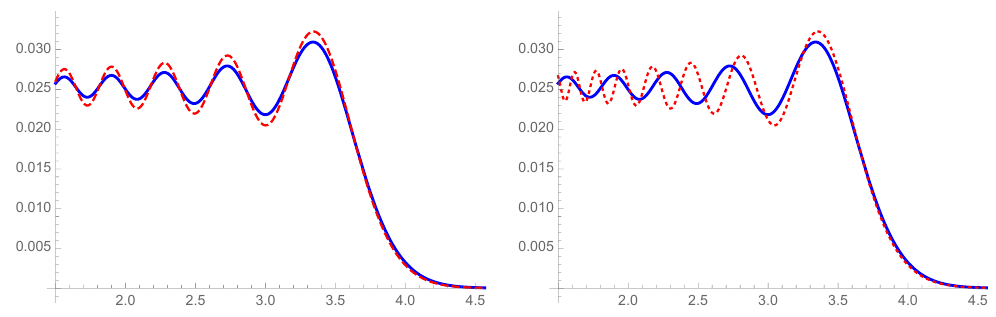
Figure 6 . Comparison of ( x; p ) (in blue solid) with its semiclassical approximations, for local Q N F 0 . On the left, the red dashed line is the expression (3.70) involving the chord area, which we analytically continue outside the classically allowed region. On the right, it is the transitional expression (3.71). We look at the slice x = p , and we set N = 20, ~ = 40 (cid:25)